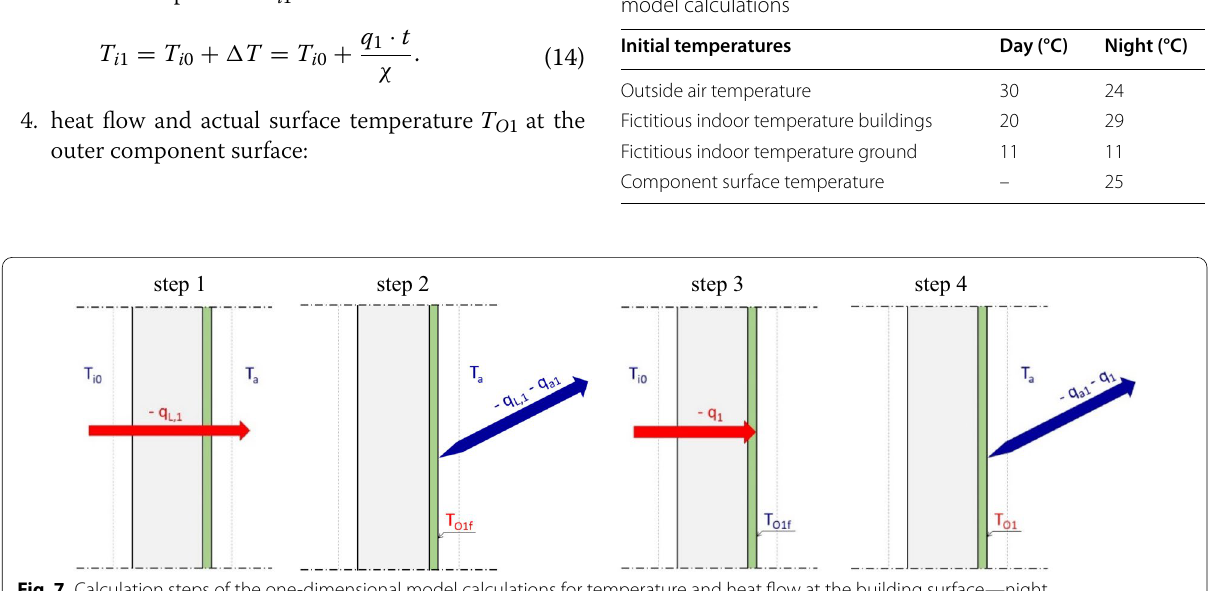
Fig. 7 Calculation steps of the one-dimensional model calculations for temperature and heat flow at the building